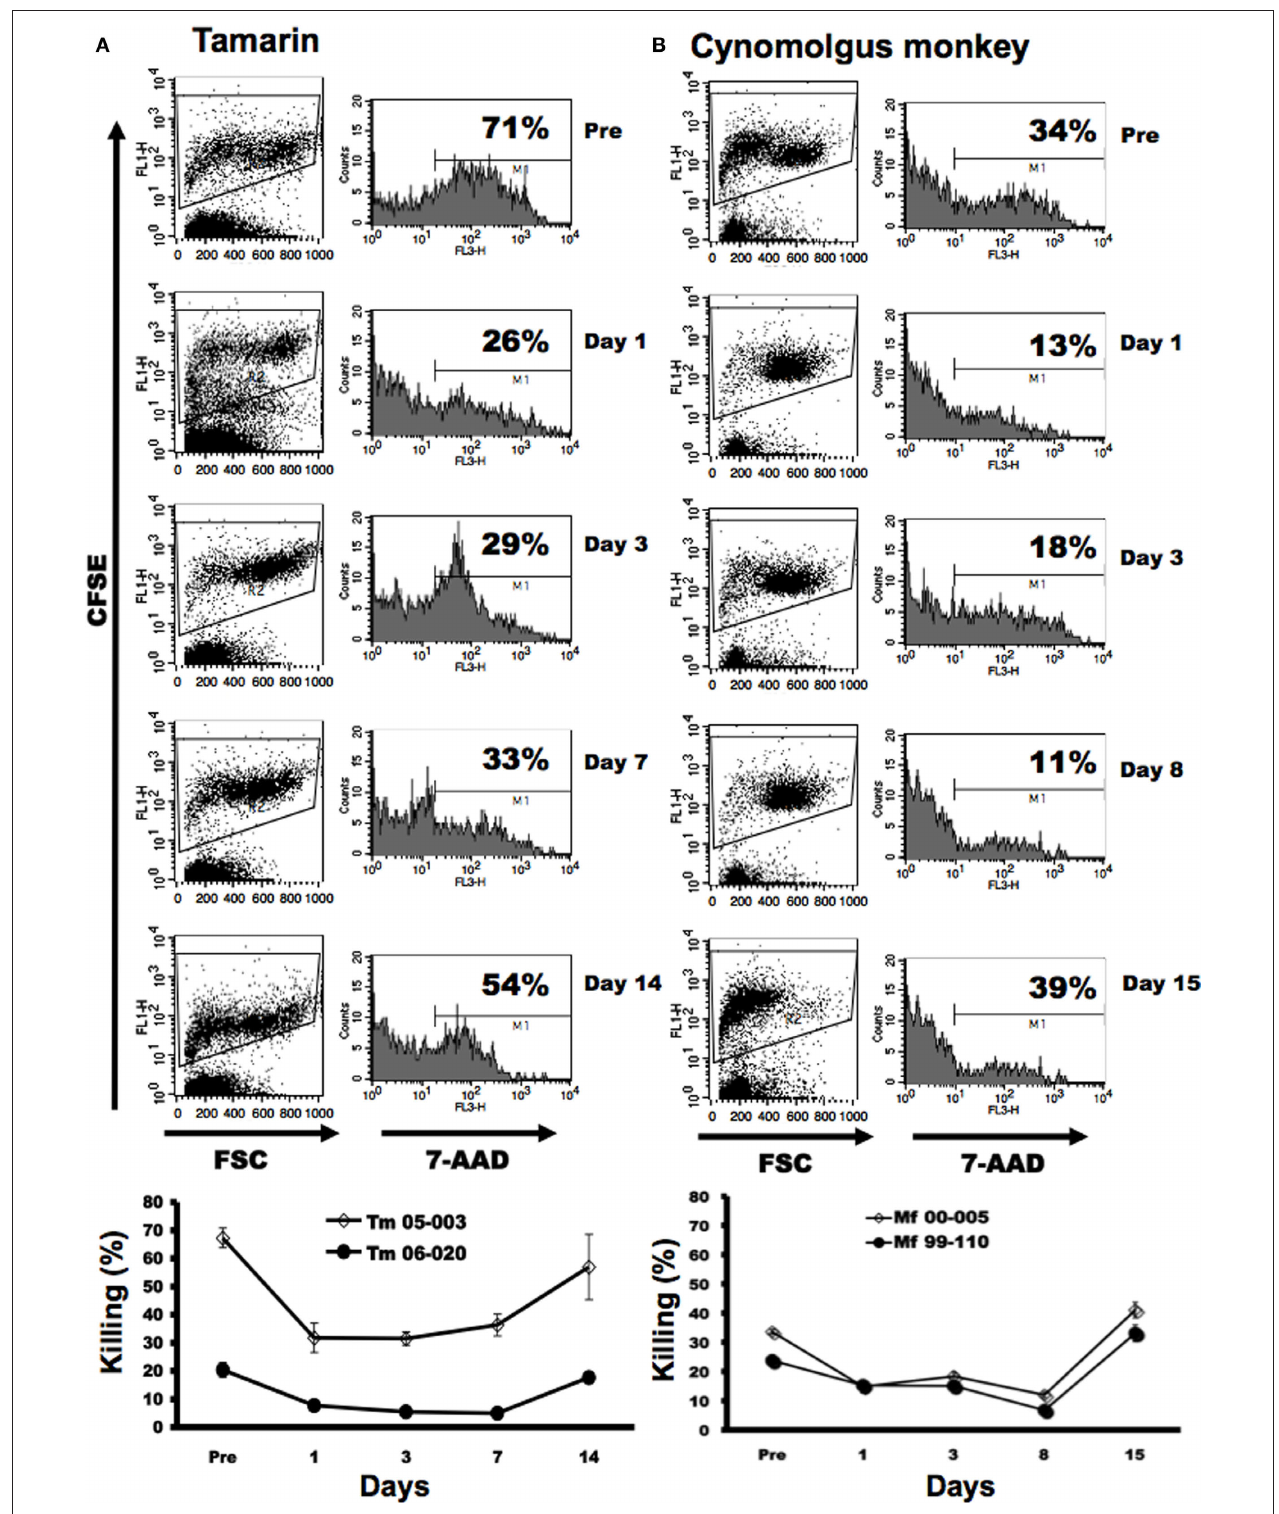
Figure 7 | Attenuation of natural killer activity by in vivo depletion of CD16 + cells. (A,B) Tamarins and cynomolgus monkeys were administered 50 mg/kg of murine 3G8 mAb. The activity was determined in PBMCs of both monkeys. Tamarins: Tm 05-003 and Tm 06-020. (B) Cynomolgus monkeys: Mf 00-005 and Mf